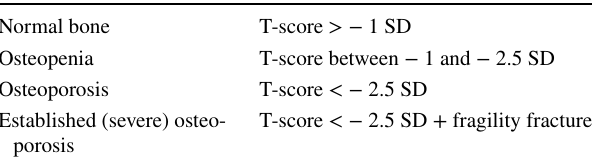
Table 1 World Health Organization cutoffs used in the diagnosis of osteoporosis (BMD at the hip) Normal